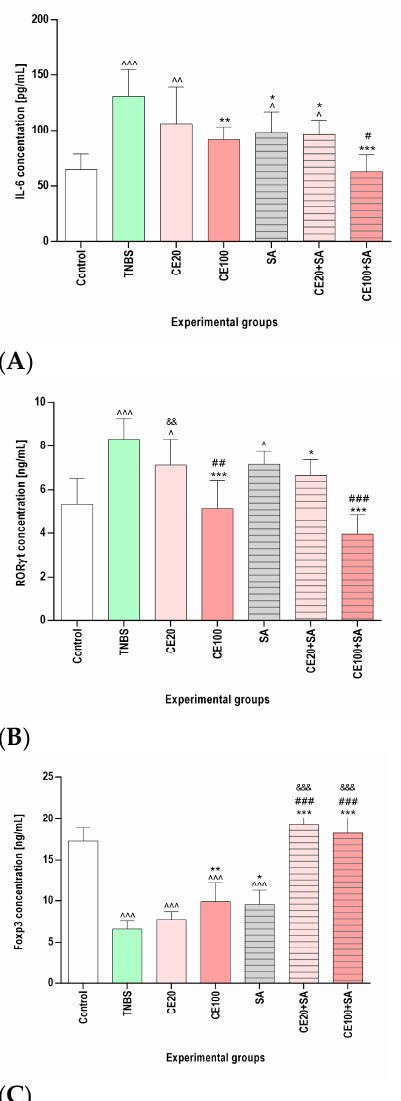
Figure 2. The impact of cornelian cherry iridoid-polyphenolic extract on the concentration of IL-6 ( A ), ROR γ t ( B ), and Foxp3 ( C ) concentration in the colon tissues in experimental groups. Control— control group; TNBS—group receiving only TNBS; CE20, CE100—groups receiving, respectively,